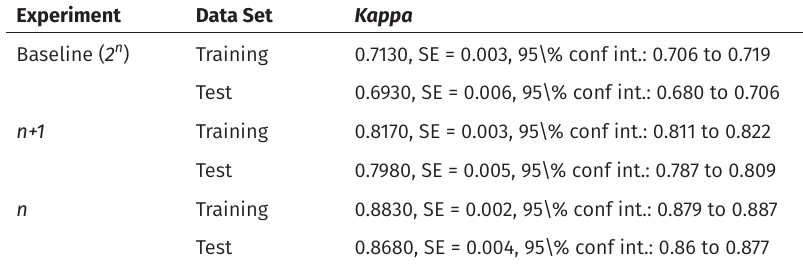
Table 10: Cohen’s Kappa Coefficients for the Training and Test data